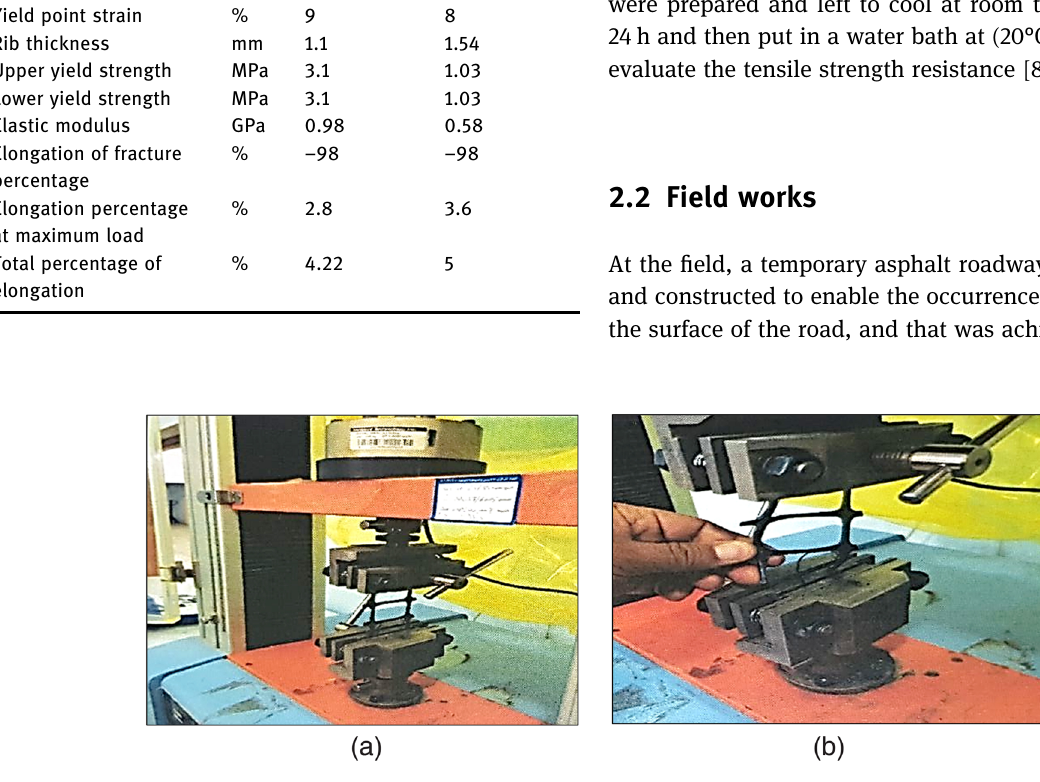
Figure 1: Universal tensile testing machine. ( a ) Before the test and ( b ) after the test.